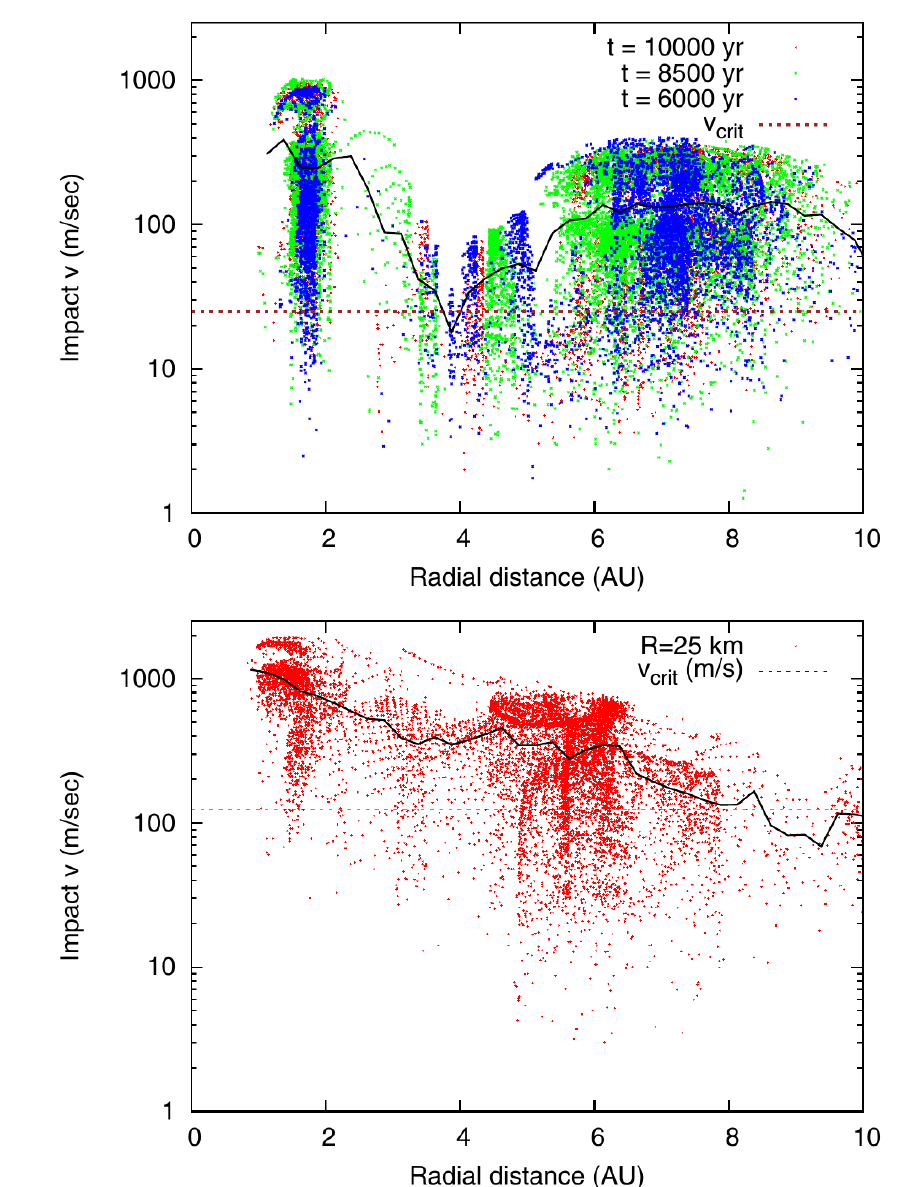
Figure 8. Figure from [74] showing at different evolutionary times the relative impact velocities for a putative planetesimal population in Kepler-16. In the upper panel the impact velocities between equal size R = 5 km planetesimals, computed at different radial distances from the baricenter of the binary, are compared with the critical erosion velocity (black dashed line). The continuous black line shows the average impact velocity for the population. In the lower panel the impact speeds are computed for larger planetesimals R = 25 km in